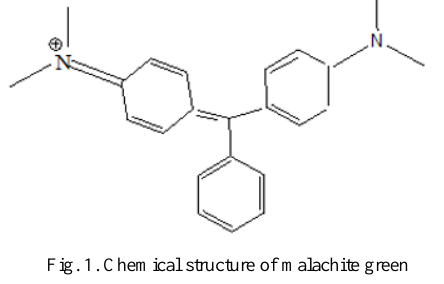
Fig. 1. Chemical structure of malachite